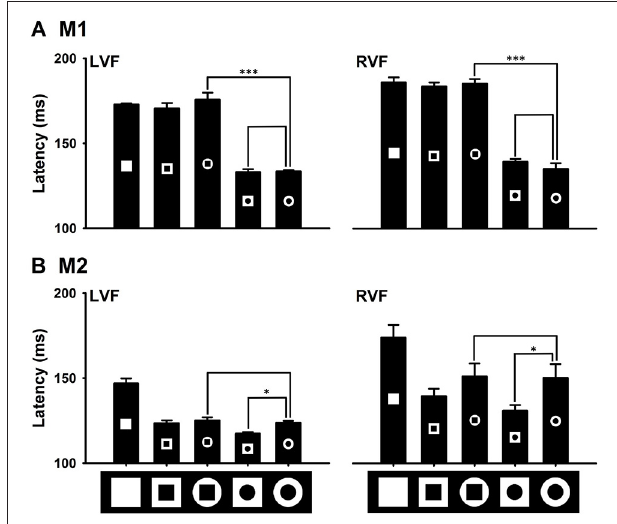
FIGURE 9 | Effects of the distinction in local features on detecting the distinction in the global feature. Local features of the outside shape of the ring did not facilitate the detection of the ring in M1, but did it in M2 (B) . Local features of the shape of the hole in the ring slowed the detection of the ring target in M1 (A) , but did not in M2 (B) . * P < 0.05; *** P < 0.001.